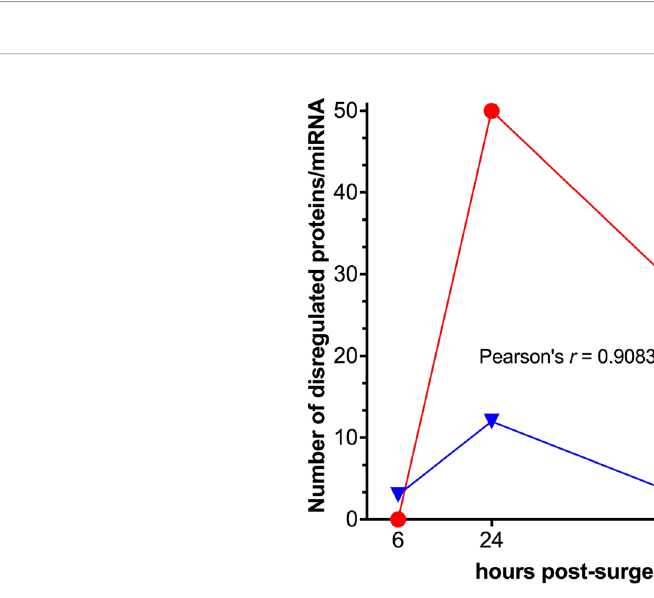
FIGURE 7 | Pathway analysis of differentially expressed miRNAs. Down- (cluster 1 from Figure 6E ) and up-regulated (cluster 2 from Figure 6E ) at 24 h post- surgery miRNAs were analyzed by the miRPath online tool (see Materials and Methods ) that determines the miRNA target mRNAs (based on experimental data) and analyses the overrepresentation of these genes in the different KEGG pathways.